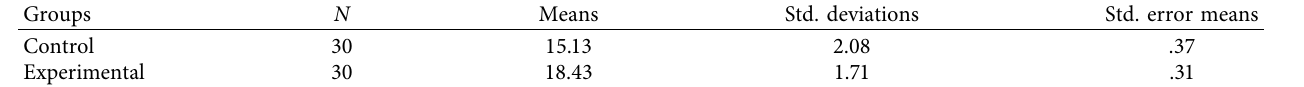
Table 13: Descriptive statistics of the experimental and control groups in the speaking